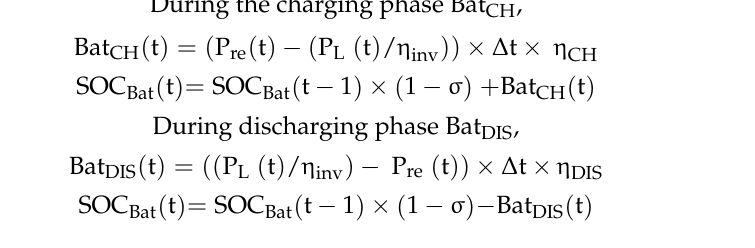
Table 4. The main parameters characteristics of the batter